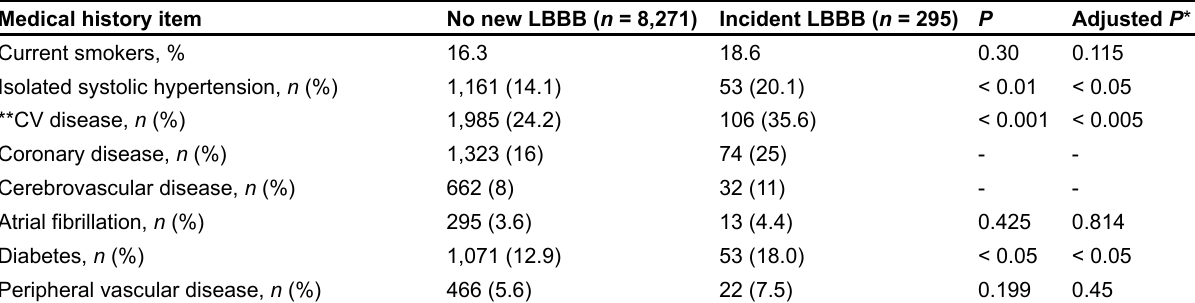
Table 2. Medical history of patients without and with incident